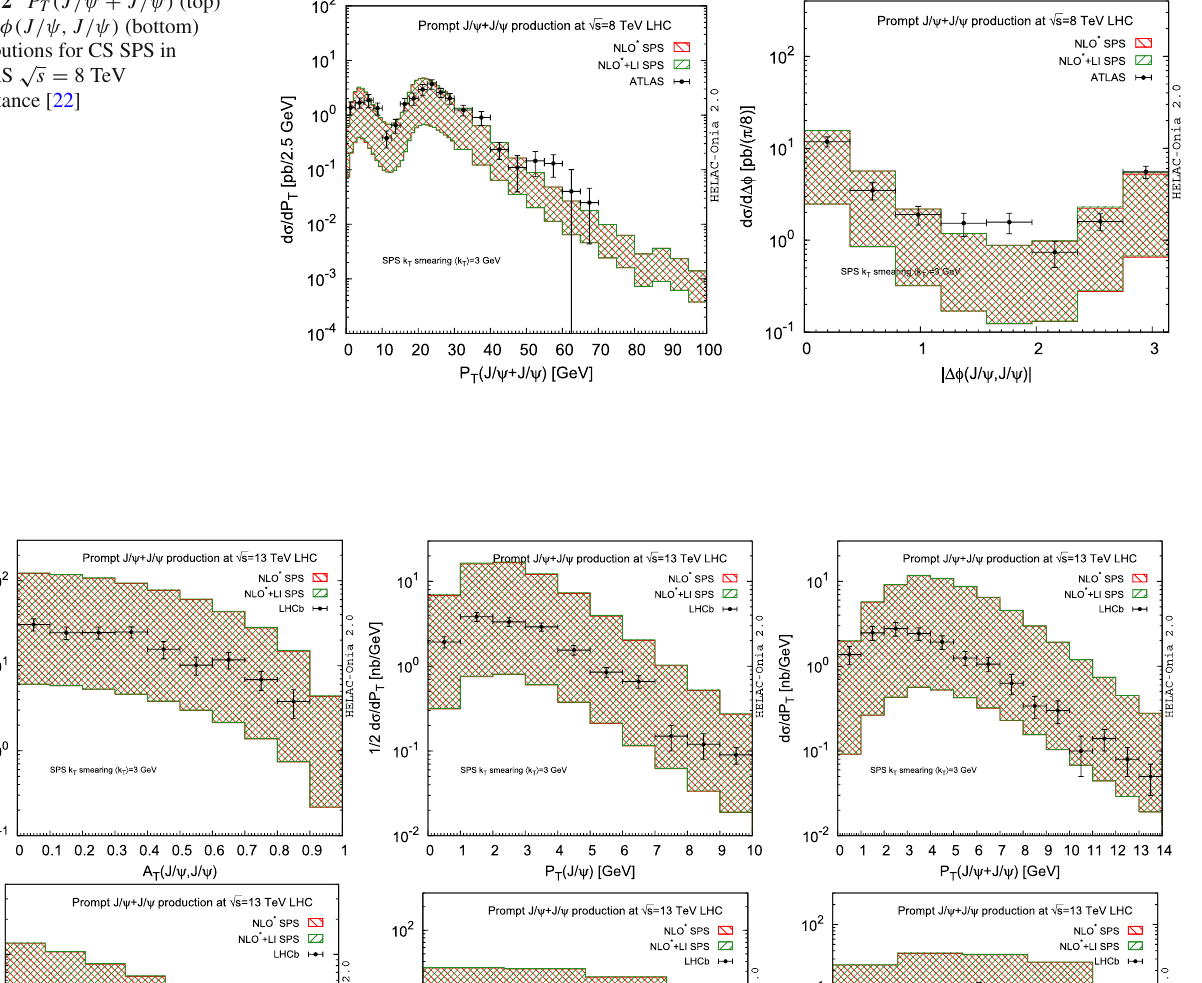
√ s = 13 TeV acceptance